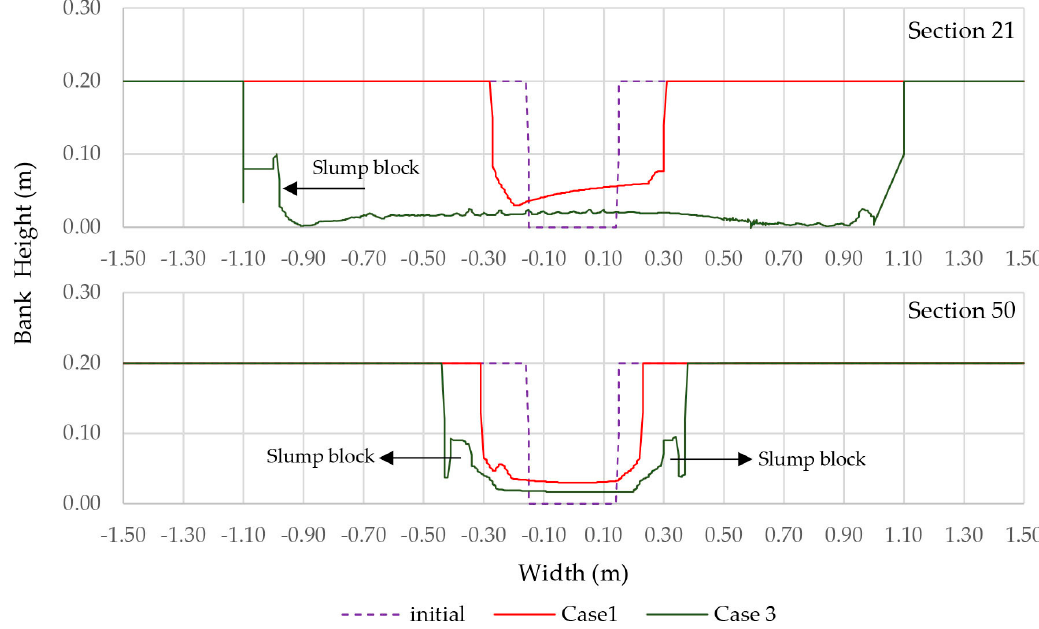
Figure 9. Comparison of cross sectional evolution for cases 1 and 3 in the straight part of the channel (S-50) and the curved part of the channel (S-21) for a simulation time of 21,600 (s).